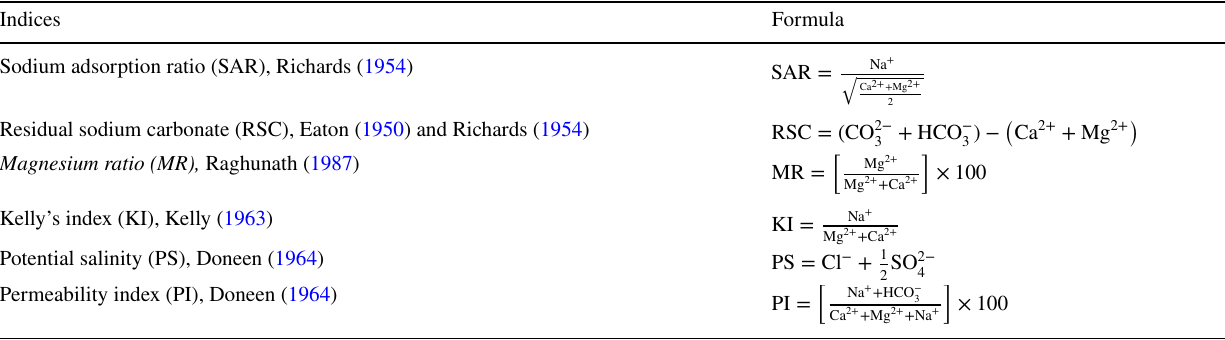
All concentrations were expressed in